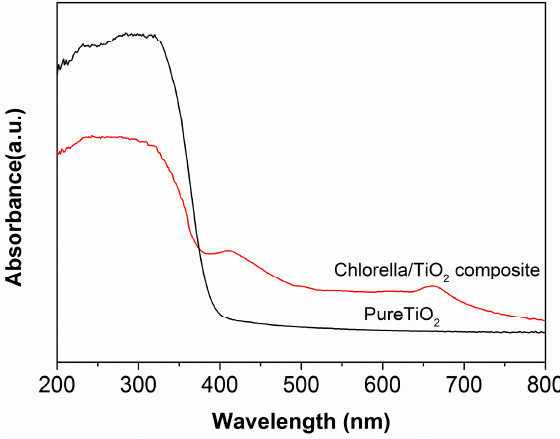
Figure 4. UV-vis diffuse reflectance spectra (DRS) of the chlorella/TiO 2 composite and the pure TiO 2 .